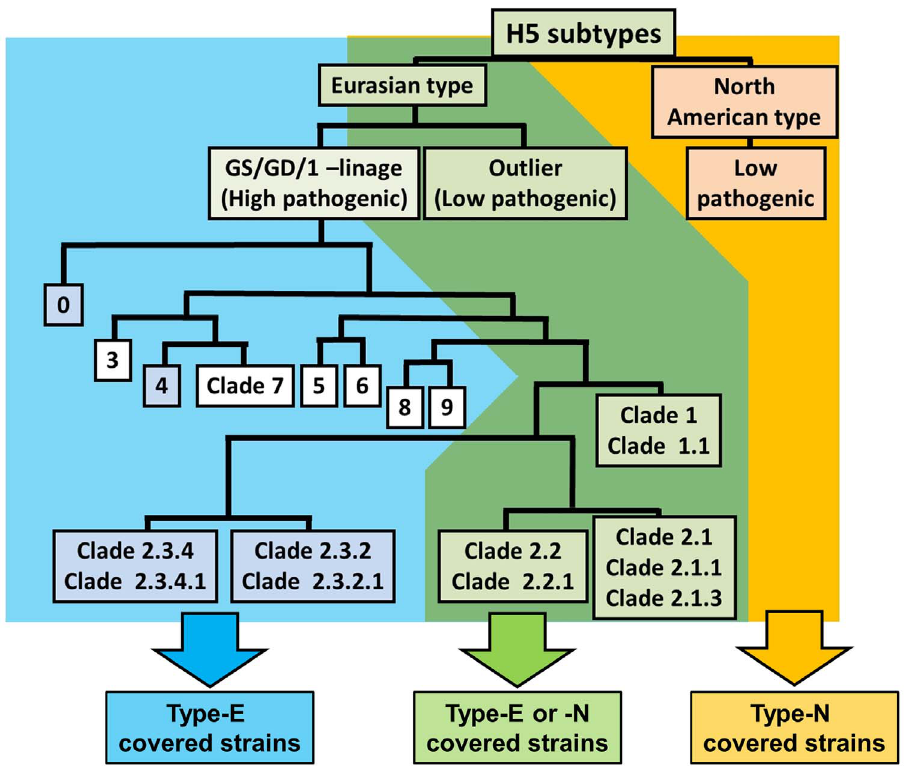
Figure 3. Schematic diagram of phylogenetic tree of H5 subtype HA protein and detectable area by each type of FLIC. White boxes indicate that no virus belonging to the clade was determined, and the boxes with a number only indicate that the clades have not been detected since 2008 or earlier.